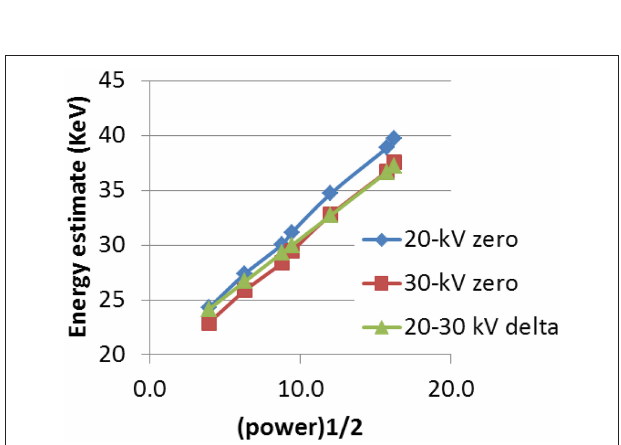
FIGURE 15 | Beam kinetic energy vs. RF input power using a 20-kV calibration (blue line), a 30-kV zero calibration (red line) and a third calibration using the power required to move the beam between the 20-kV and 30-kV calibration positions, for a fixed dipole field (green